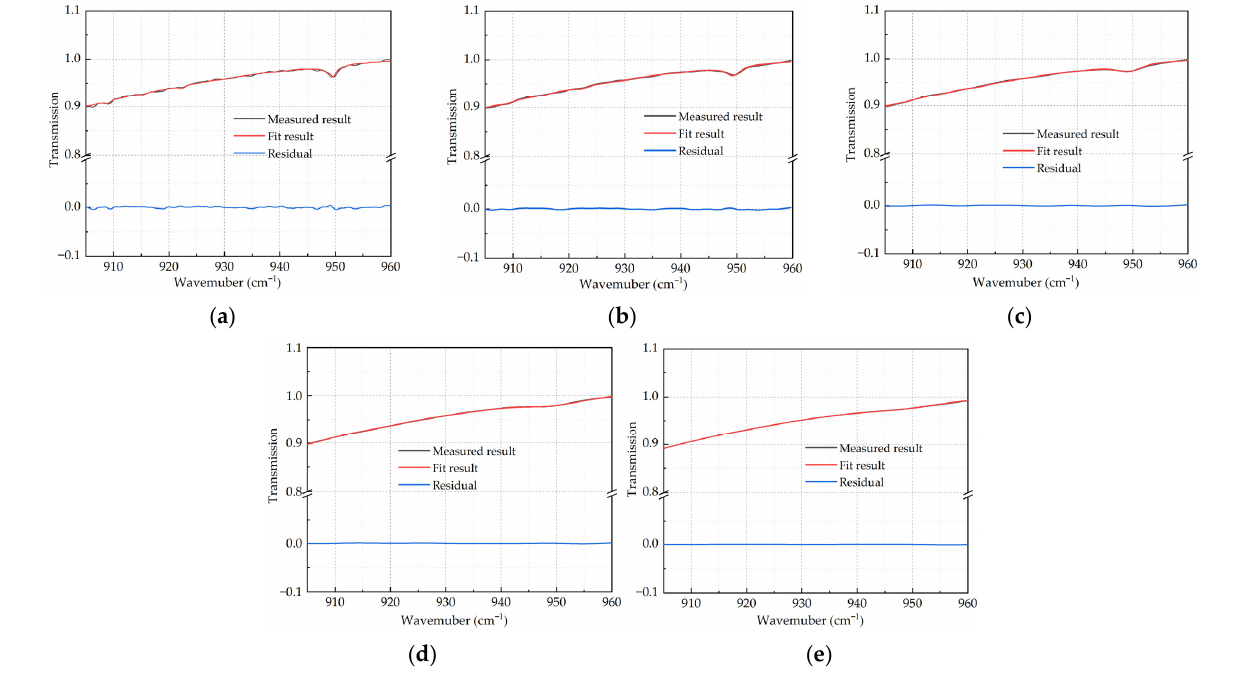
Figure 6. ( a ) the fitted C 2 H 4 spectral result and its residual at 1 cm − 1 ; ( b ) the fitted C 2 H 4 spectral result and its residual at 2 cm − 1 ; ( c ) the fitted C 2 H 4 spectral result and its residual at 4 cm − 1 ; ( d ) the fitted C 2 H 4 spectral result and its residual at 8 cm − 1 ; and ( e ) the fitted C 2 H 4 spectral result and its residual at 16 cm − 1 .